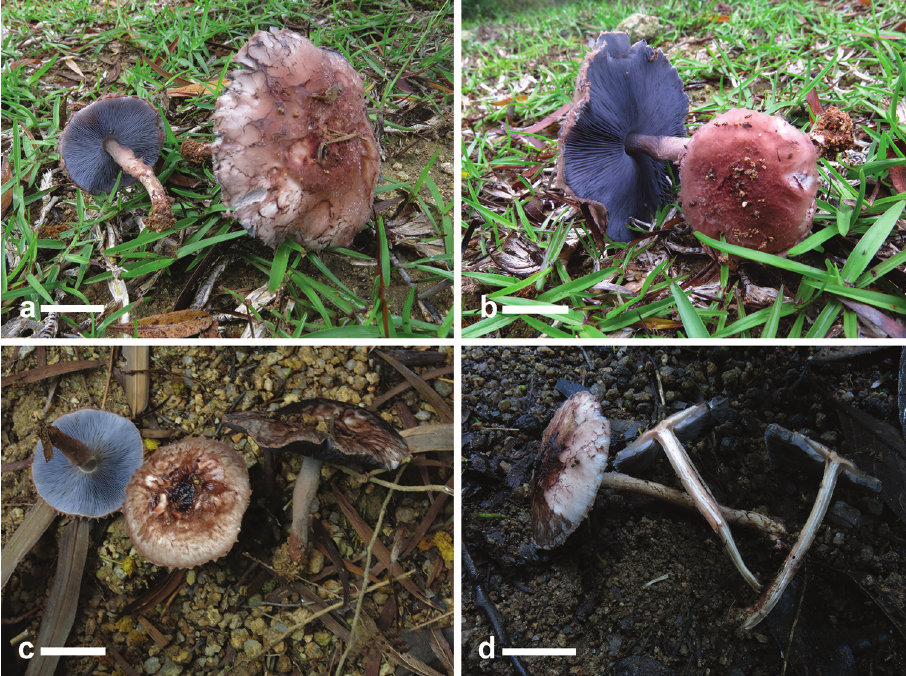
Figure 6. Basidiomata of Heinemannomyces splendidissimus . a Basidiomata showing leaden-blue lamellae and floccose pileus surface (GDGM 46633) b Basidiomata showing dark blue lamellae and floccose pileus surface (GDGM 46633) c Basidiomata showing blue lamellae and slightly depressed pileus disc (GDGM 46634) d Basidiomata showing pileus surface and a reddening context when cut (GDGM 46635). Scale bars: 20